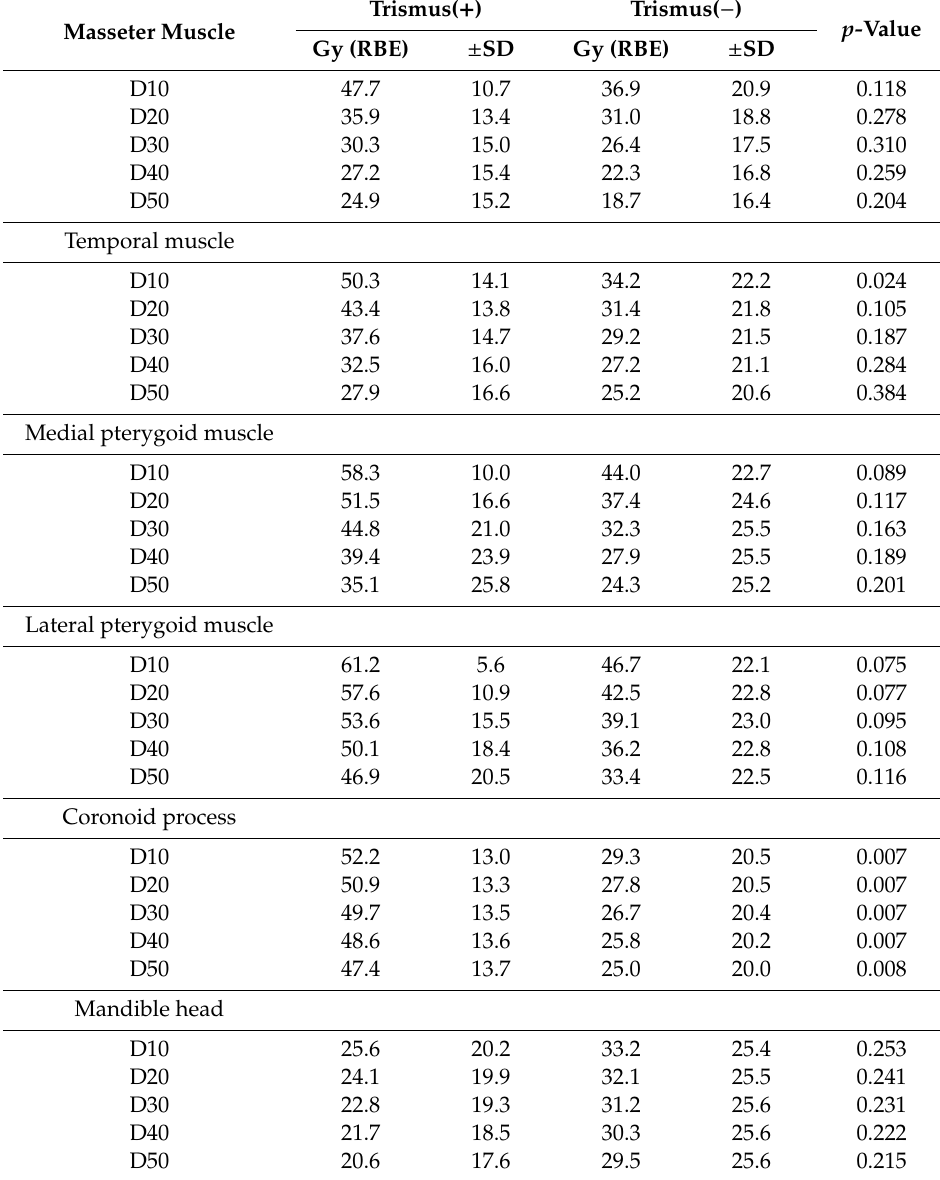
Table 2. Dose received by temporomandibular joint-related muscles and